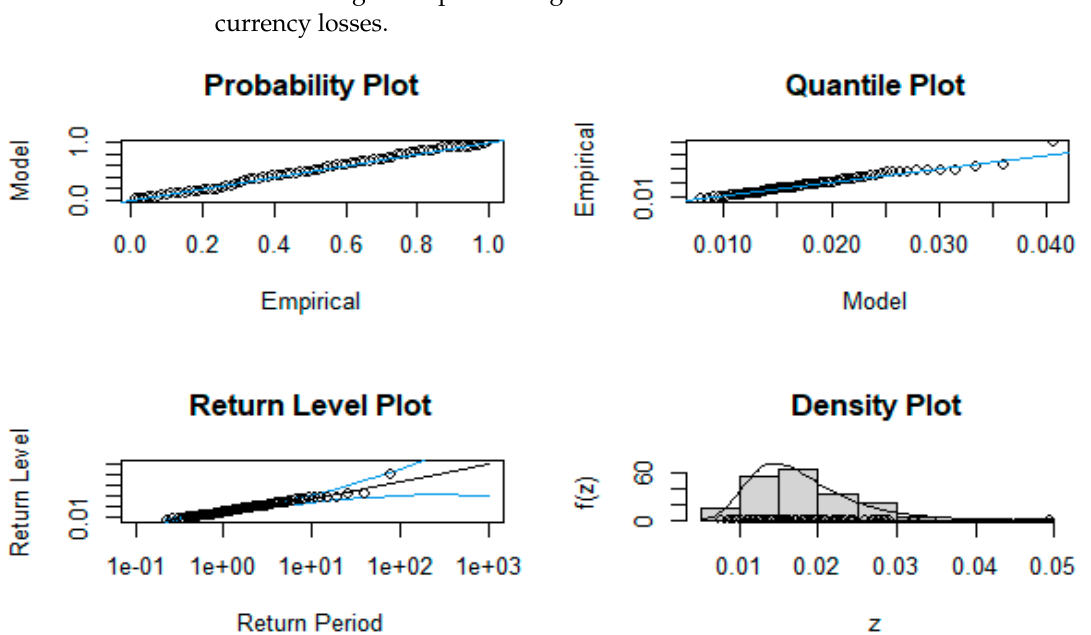
Figure 9. Model diagnostics for the maxima of the BTC/USD (lower tail, loses or minima returns).